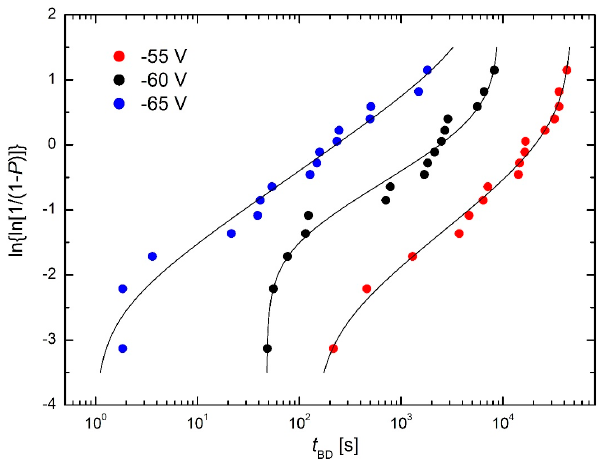
Figure 4. TTT plot of the time-to-breakdown of Hf-doped Ta 2 O 5 /SiO 2 capacitors under stress voltage − 4.5 V at the presented temperatures [8].